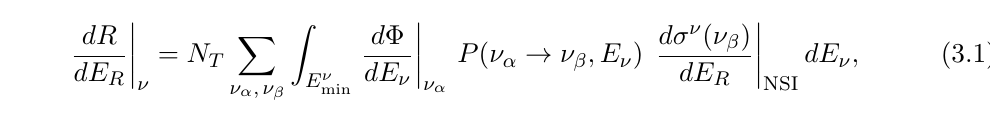
Figure 1 . (cid:1) (cid:31) 2 as a function of the NC-NSI parameters (cid:15) f;V ments and COHERENT data (see text for